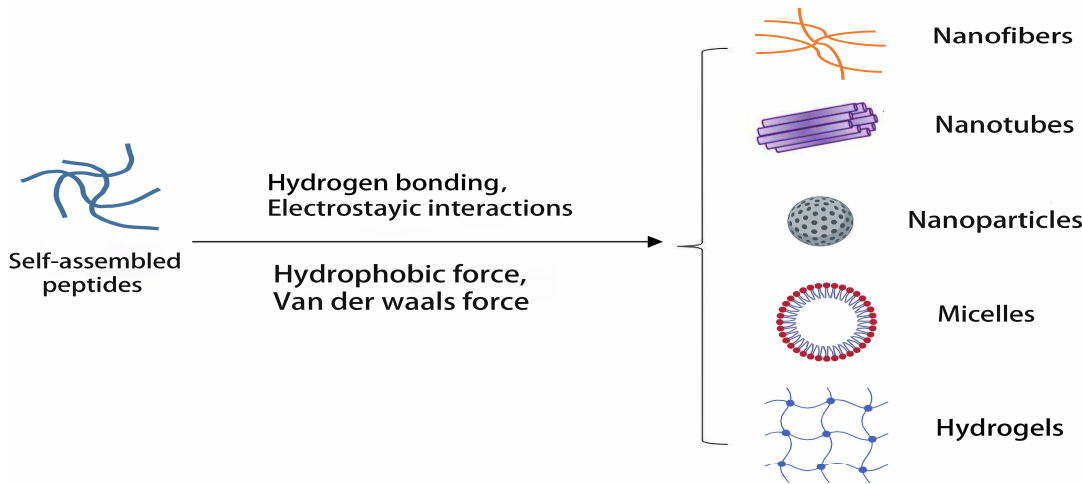
Figure 1. Nanostructures formed by self-assembled peptides.